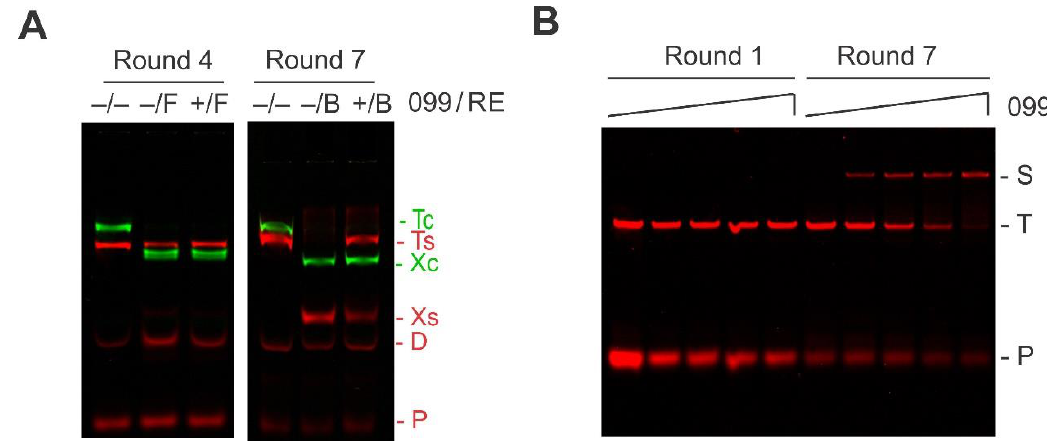
Figure 2. Validation of TTHB099–binding DNA sequences. ( A ) Shown are IR fluorescence images of restriction endonuclease protection assays made with DNA from Round 4 and 7 of REPSA selection. The presence (+) or absence (−) of TTHB099 and IISRE FokI (F) or BpmI ( B ) are indicated above each lane. The electrophoretic mobility of the intact (T) and cleaved (X) IRD8-labeled REPSAis control DNA (green, T c and X c ), IRD7-labeled ST2R24 selection template (red, T s and X s ), primer-dimers (D), as well as the IRD7_ST2R primer (P) are indicated at the right of the figure and color-coded to match the fluorescently labeled DNA present. (B) Shown are IR fluorescence images of electrophoretic mobility shift assays made with DNA mixtures obtained from Round 1 (left lanes) and Round 7 (right lanes) of REPSA selection incubated with increasing concentrations of TTHB099 protein (from left to right: 0, 5.06, 50.6, 506, and 5060 nM TTHB099). The electrophoretic mobility of a single protein-DNA complex (S) as well as the uncomplexed ST2R24 selection template (T) and IRD7_ST2R primer (P) are indicated at the right of the figure.